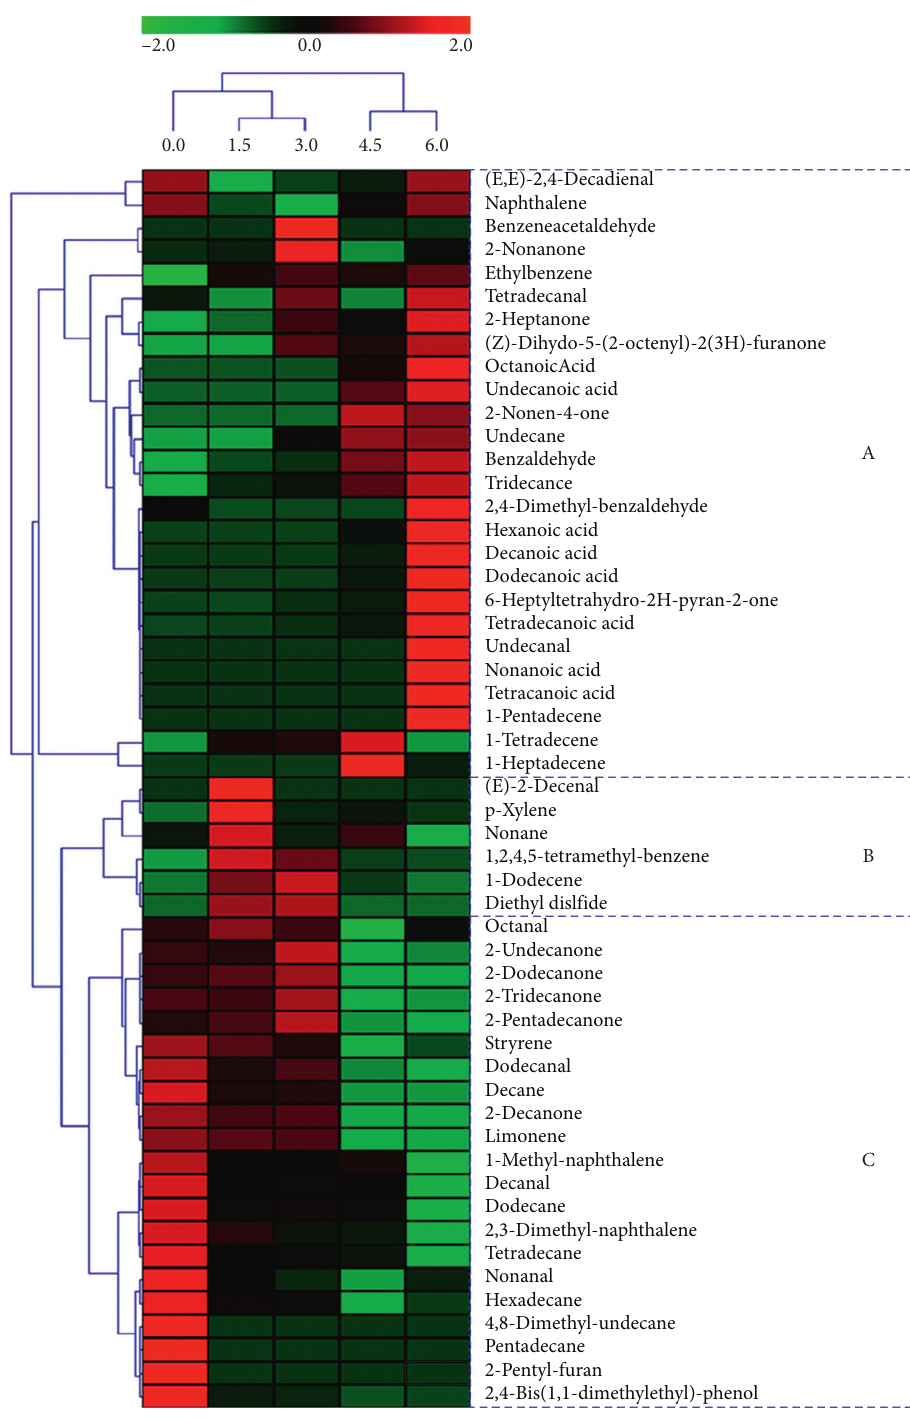
Figure 1: Heat map plots clusters of volatile compounds in yogurt fermented by S. thermophilus at different time points based on the content. Green colors indicate that volatile compound levels were less than the mean levels during yogurt fermentation, while red colors indicate that volatile compound levels were higher than the mean